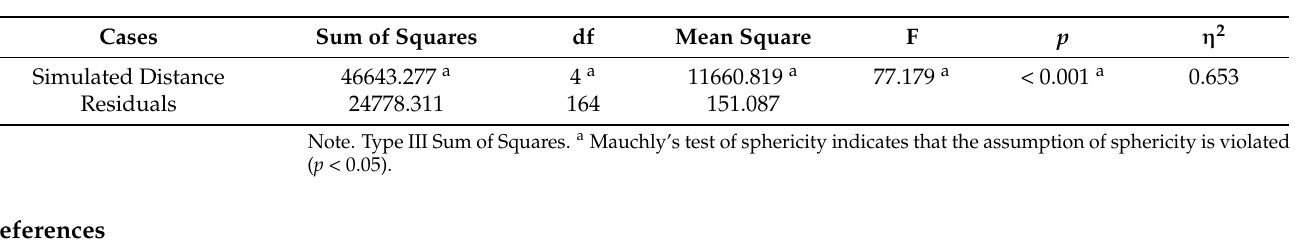
Table A8. Exp 3: Group 2—repeated-measures ANOVA—comparing target